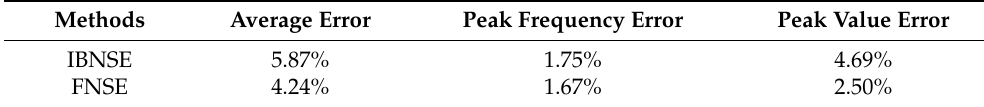
Table 2. Transmission loss errors corresponding to the FNSE and the IBNSE methods. Methods